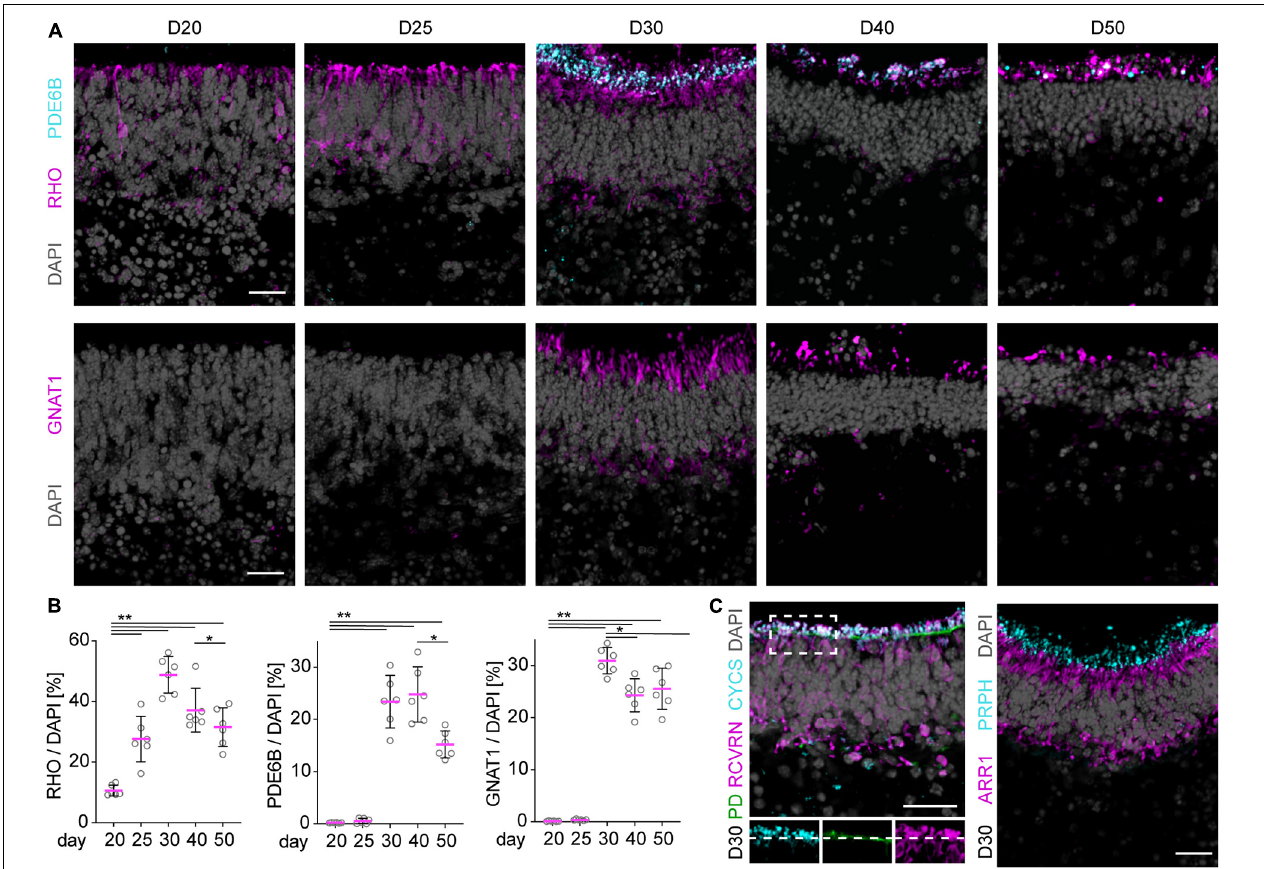
FIGURE 3 | Photoreceptor maturation in MROs. (A) Representative images and (B) quantitative analysis of immunostained MRO cryosection. Rod specific marker RHO is already detected in a few cells in the ONL at day (D) 20 and becomes upregulated at D25. By D30, RHO is localized to the apical processes of the photoreceptors, and PDE6B as well as GNAT1 expression are detected in the same region. At later timepoints (D40, D50), all of these markers are still detected in the same region of the organoid, but the structures appear sparser and more disorganized. For quantification, pixel area above the threshold was measured for each marker and normalized to DAPI. Each dot represents an organoid, organoids were derived from N = 2 independent experiments. * p < 0.001, ** p < 0.0001 (ANOVA). (C) Photoreceptors develop mitochondria-rich inner segments as indicated by localization of mitochondrial marker CYCS in apical RCVRN-positive processes above the outer limiting membrane highlighted by Phalloidin (PD) staining. The majority of the photoreceptors are rods (ARR1-positive). Localization of PRPH apical to ARR1 signal suggests the formation of outer segment like structures. Scale bars: 25 µ